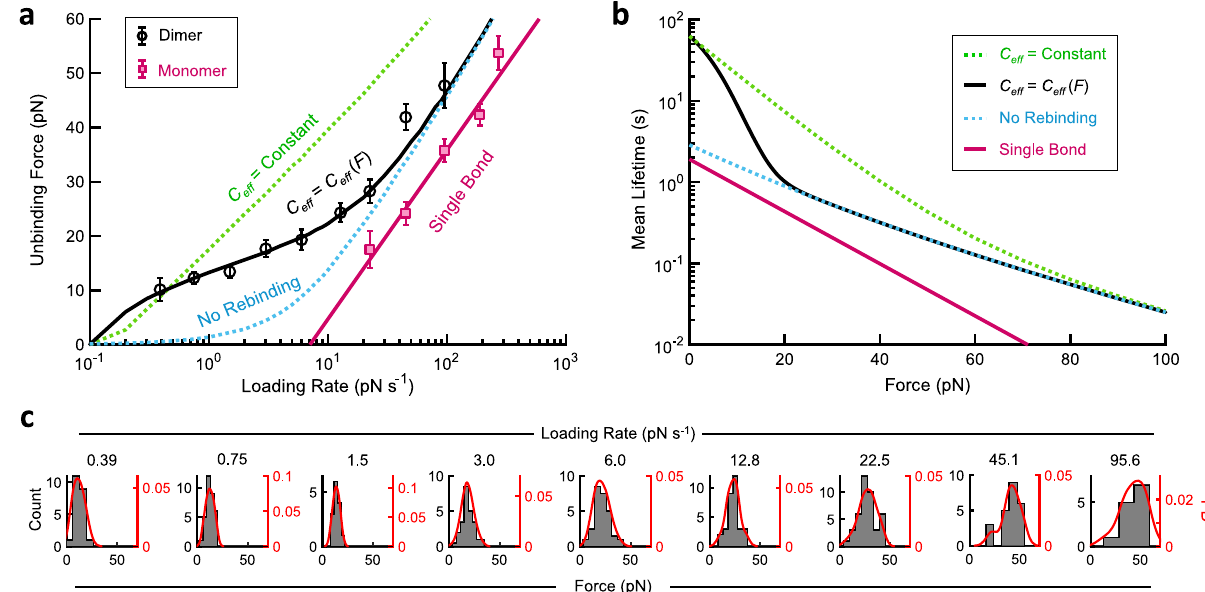
Fig. 3 The strength of the tip-link connection under force. a Unbinding force as a function of loading rate for full-length dimers in 2 mM Ca 2 + . Displayed are most-probable unbinding forces for double-bond full-length dimer proteins (black circles, n = 247 unbinding events) and single-bond unbinding forces from Fig. 1f (magenta squares, n = 411 unbinding events). Error is shown as the optimal bandwidth from a kernel density estimation. Dimer unbinding forces show enhanced strength relative to single bonds, particularly at slow loading rates. A kinetic model that incorporates rebinding was fi tted to the double- bond interaction (solid black line). A no-rebinding model is shown as the blue dashed line; a rebinding model with constant C eff is shown as the green dashed line. b Calculated mean lifetime from the model fi ts in a . At forces below about 20 pN, the tip link connection has a pronounced increase in lifetime relative to the single bond due to avidity. At low forces, this results from a combination of force-sharing and rebinding. At high force, unbinding becomes faster and rebinding becomes slower, so load sharing dominates, resulting in half the sensitivity to force relative to a single bond. c Histograms of unbinding forces plotted in a . Unbinding forces at each loading rate were systematically binned using the Freedman – Diaconis rule to yield N total bins of width Δ F . Bin centers were systematically chosen to yield the most likely unbinding force with the maximum number of counts. A kernel smoothing function density estimate is overlaid on the binned unbinding force